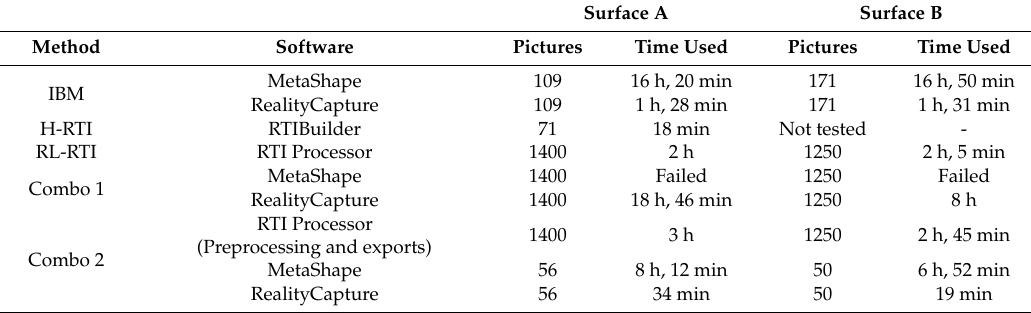
Table 2. The table illustrates the time-e ffi ciency of post-processing for each method on each recorded surface. The table shows that RTI post-processing is much faster than IBM post-processing, though the latter is greatly improved by using RealityCapture instead of MetaShape. Combo 1 uses IBM software to post-process large number of pictures and has low time-e ffi ciency. The post-processing done with Combo 2 is done in two stages; the original pictures are first processed by RTI software, subsequentially the resulting images are post-processed by IBM software. This process is a lot more time-e ffi cient, since the IBM software processes a smaller number of